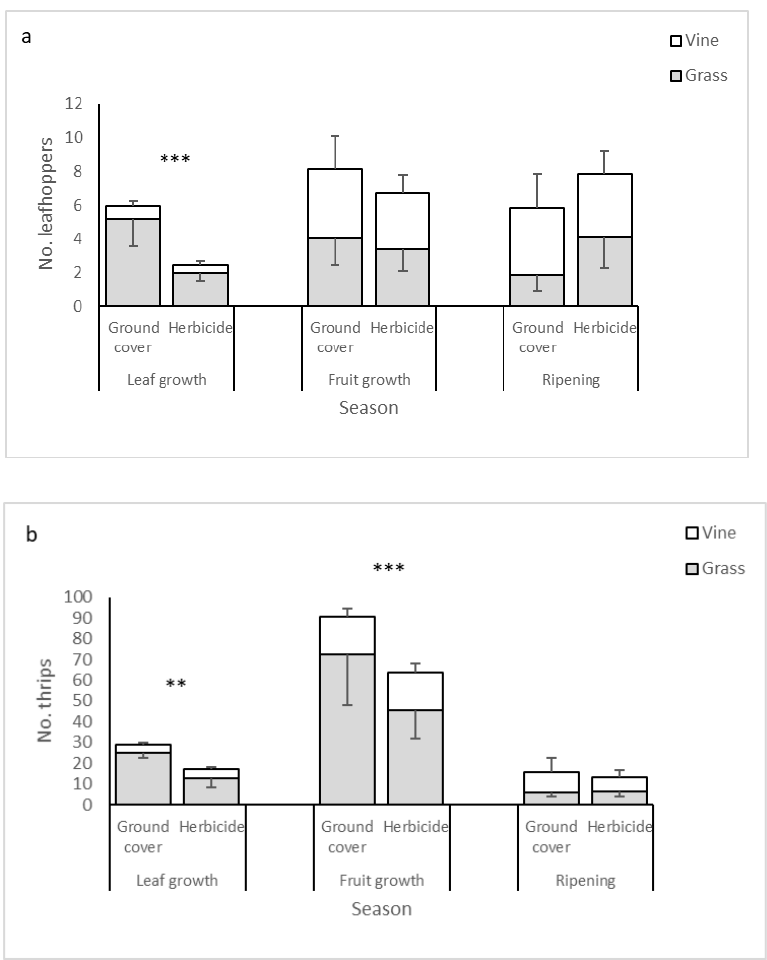
Figure 3. Mean ± SE abundance of leafhoppers ( a ) and thrips ( b ) in the suction samples from the grass (grey bars) and vine (white bars) habitats. Asterisks denote significant differences between treatments in Tukey’s post-hoc tests (** p < 0.01, *** p < 0.001).